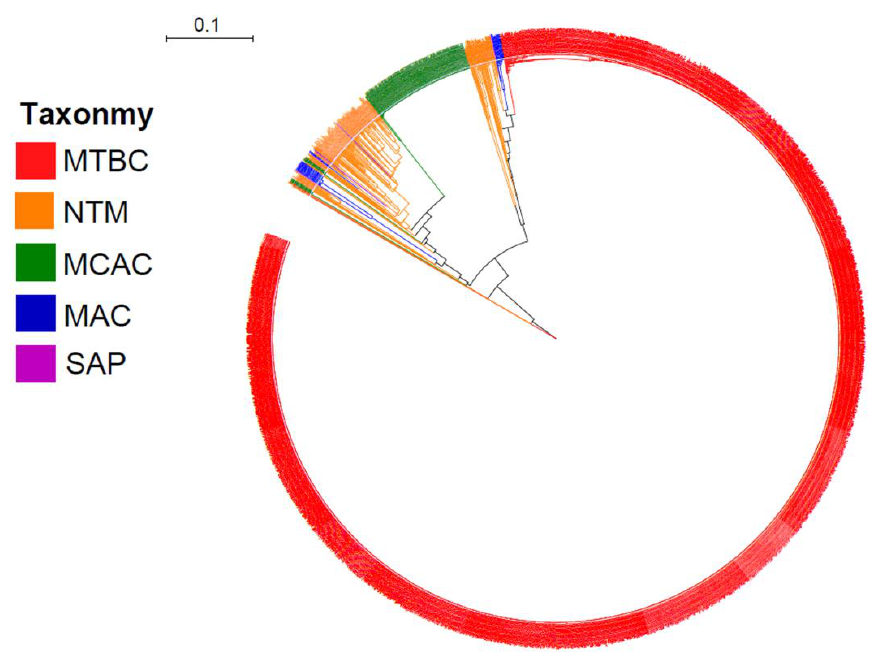
Figure 1. Phylogenetic tree of the cytochrome P450 monooxygenases (CYPs/P450s). Different mycobacterial categories are indicated indi ff erent colors.